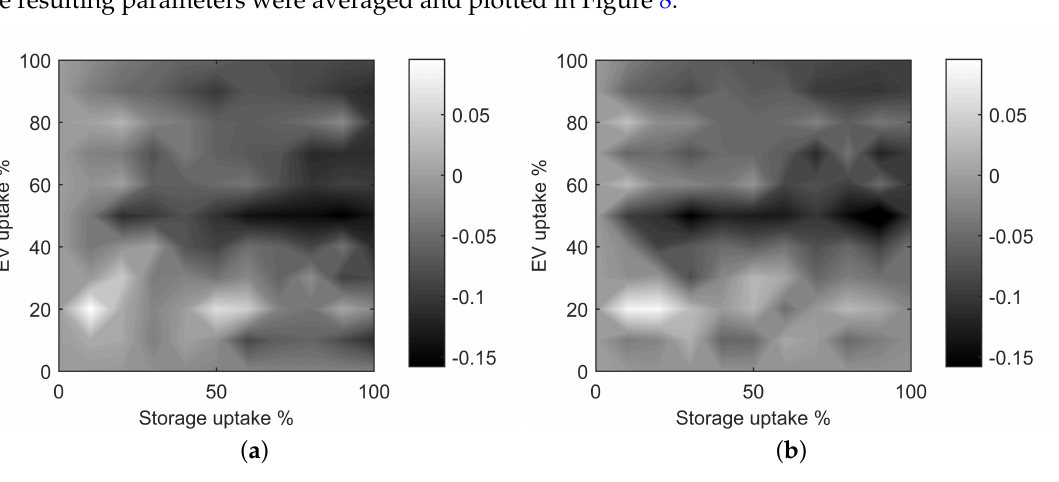
Figure 8. Comparison of voltage improvement indices (i.e., ζ ∗ ) for ( a ) AIMD and ( b ) AIMD+. (a) ζ ∗ indices (AIMD); (b) ζ ∗ indices D C